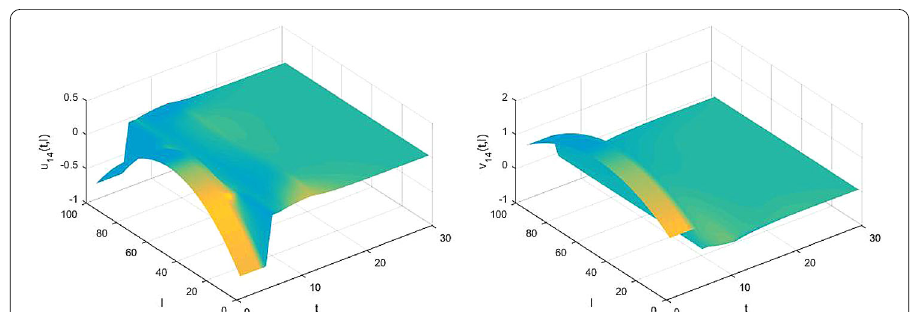
Figure 4 The trajectory of u 14 ( t , l ) and v 14 ( t , l ).